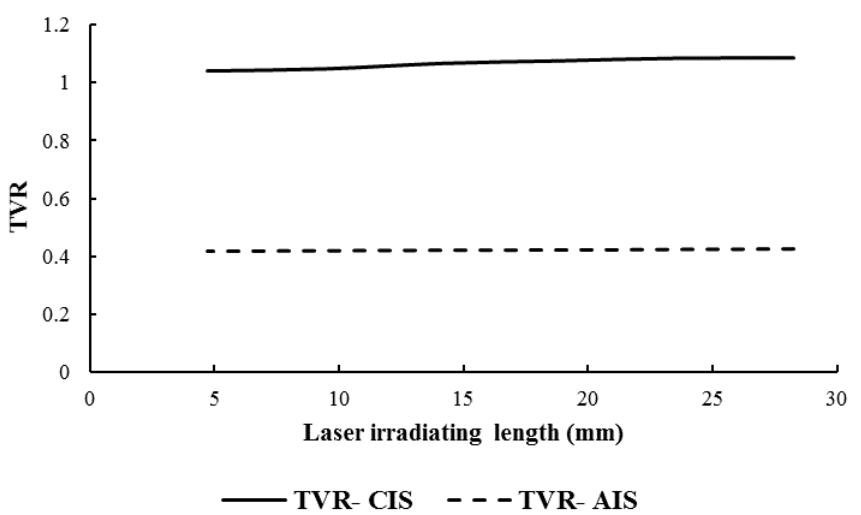
Figure 7. The effects of irradiating scheme on thickness variation ratio (TVR) of the laser-bent tubes.